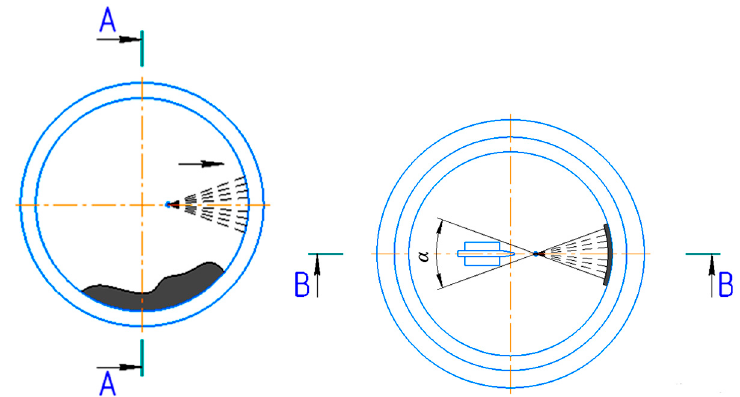
Figure 6. The scheme for applying the laser coating.